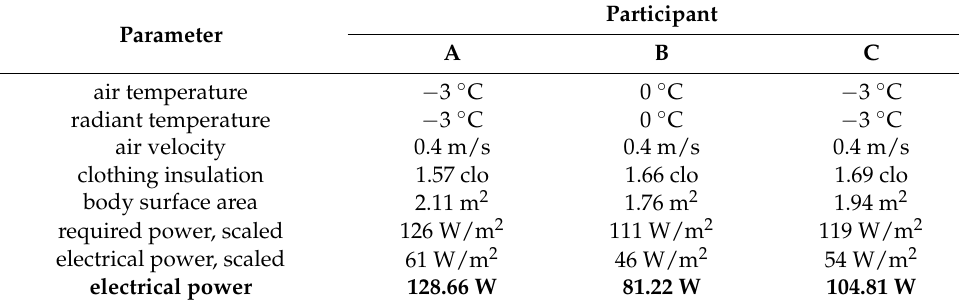
Table 3. Input data for ISO 11079